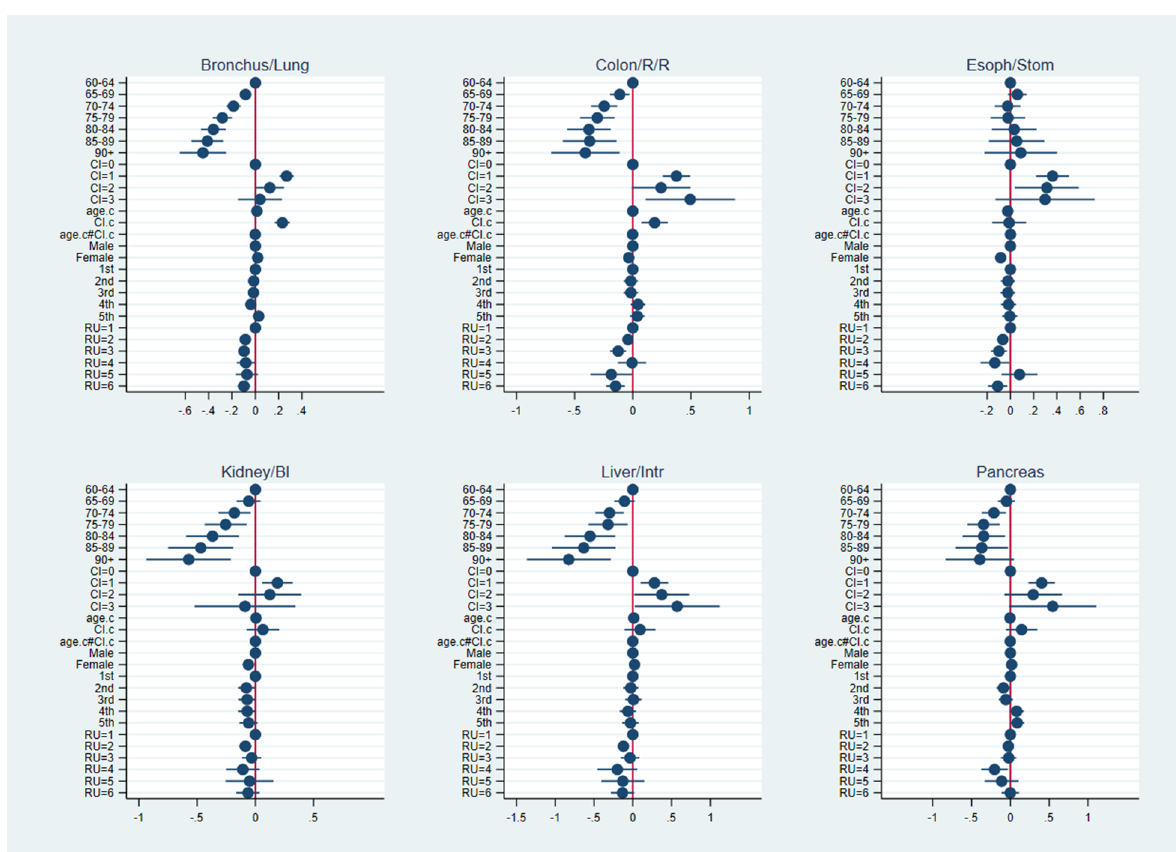
Supplementary Figure 6: Graphical representation of GLM results including interaction term (interaction between age and comorbidity burden) for the different cancer types